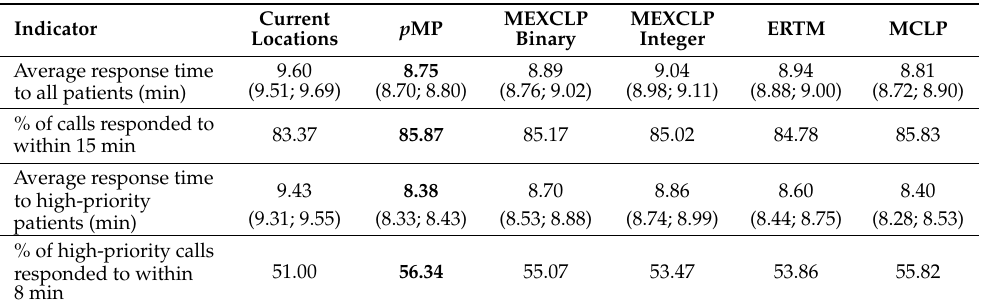
Table 3. Performance indicators for different distributions of the EMS stations in the district of Prešov, LandScan model of demand.